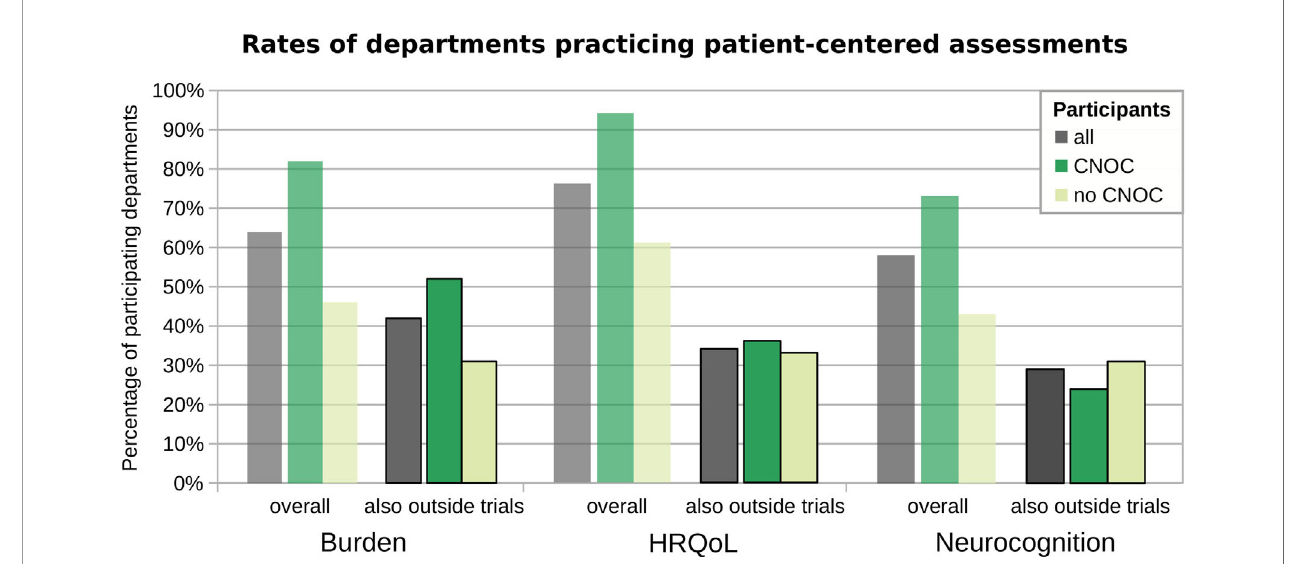
FIGURE 2 | Assessment practice overall versus not exclusive to clinical trials. The y-axis represents the percentages of departments performing the respective assessment types, across all participating departments (grey) and grouped by CNOC (green) versus no CNOC (light green) status. Burden: psycho-oncological burden, depression, and anxiety.